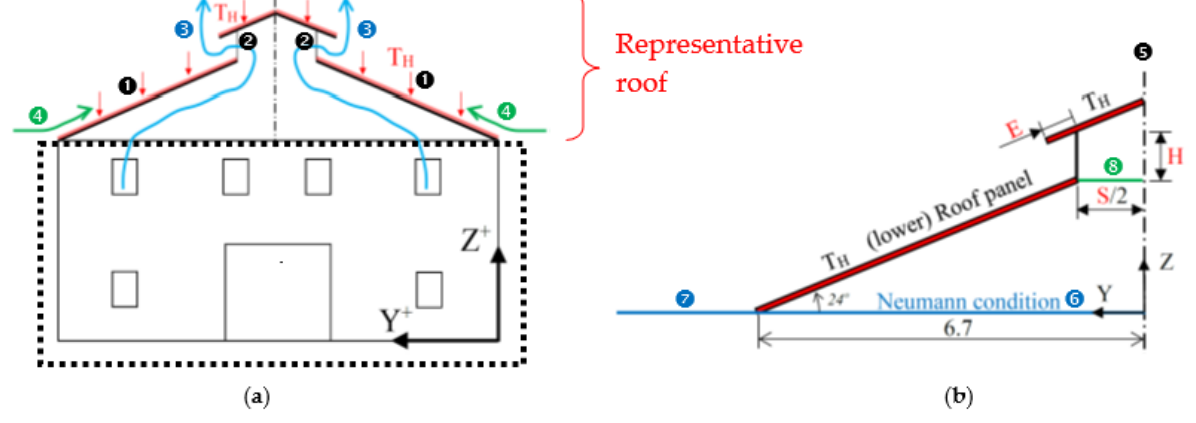
Figure 2. Development process of the physical model in this study (not to scale; units: m). ( a ) Rep- resentative roof and the workshop space below; ( b ) Physical model.